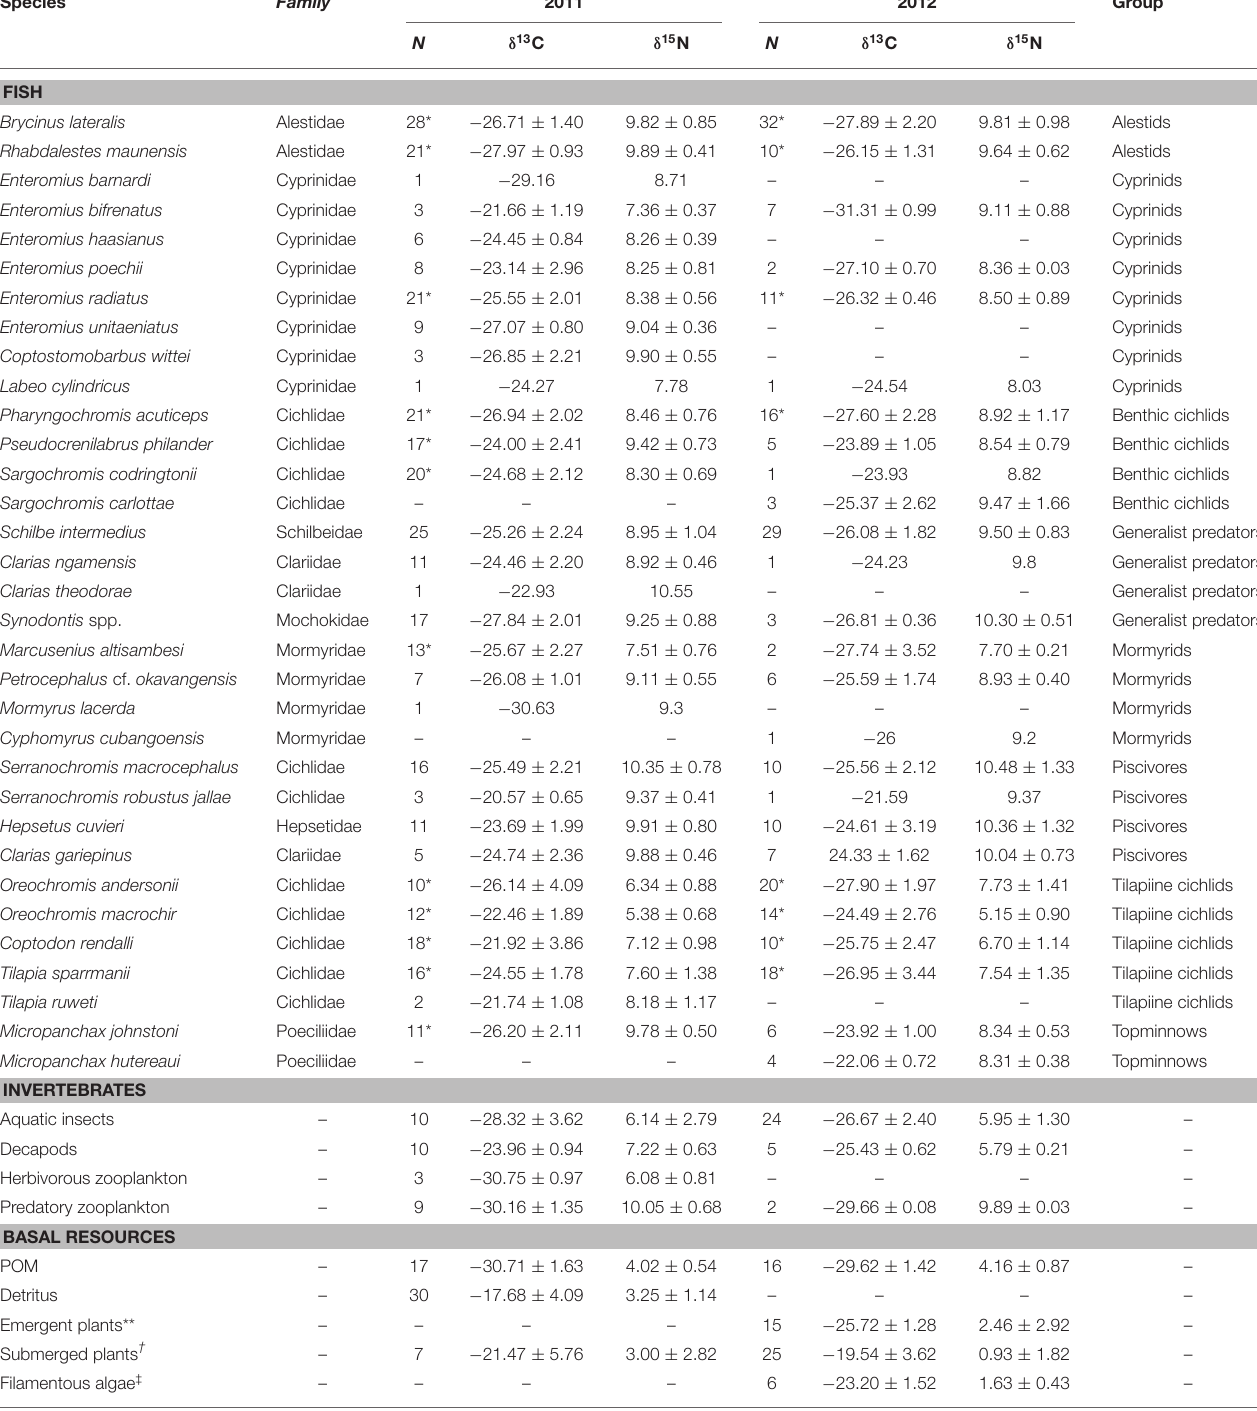
TABLE 1 | Carbon and nitrogen stable isotope values (mean ± standard deviation) of fish species, invertebrate groups and basal carbon sources sampled in Lake Liambezi in 2011 and 2012, and the taxonomic/feeding group to which species were assigned for broad food web analysis.